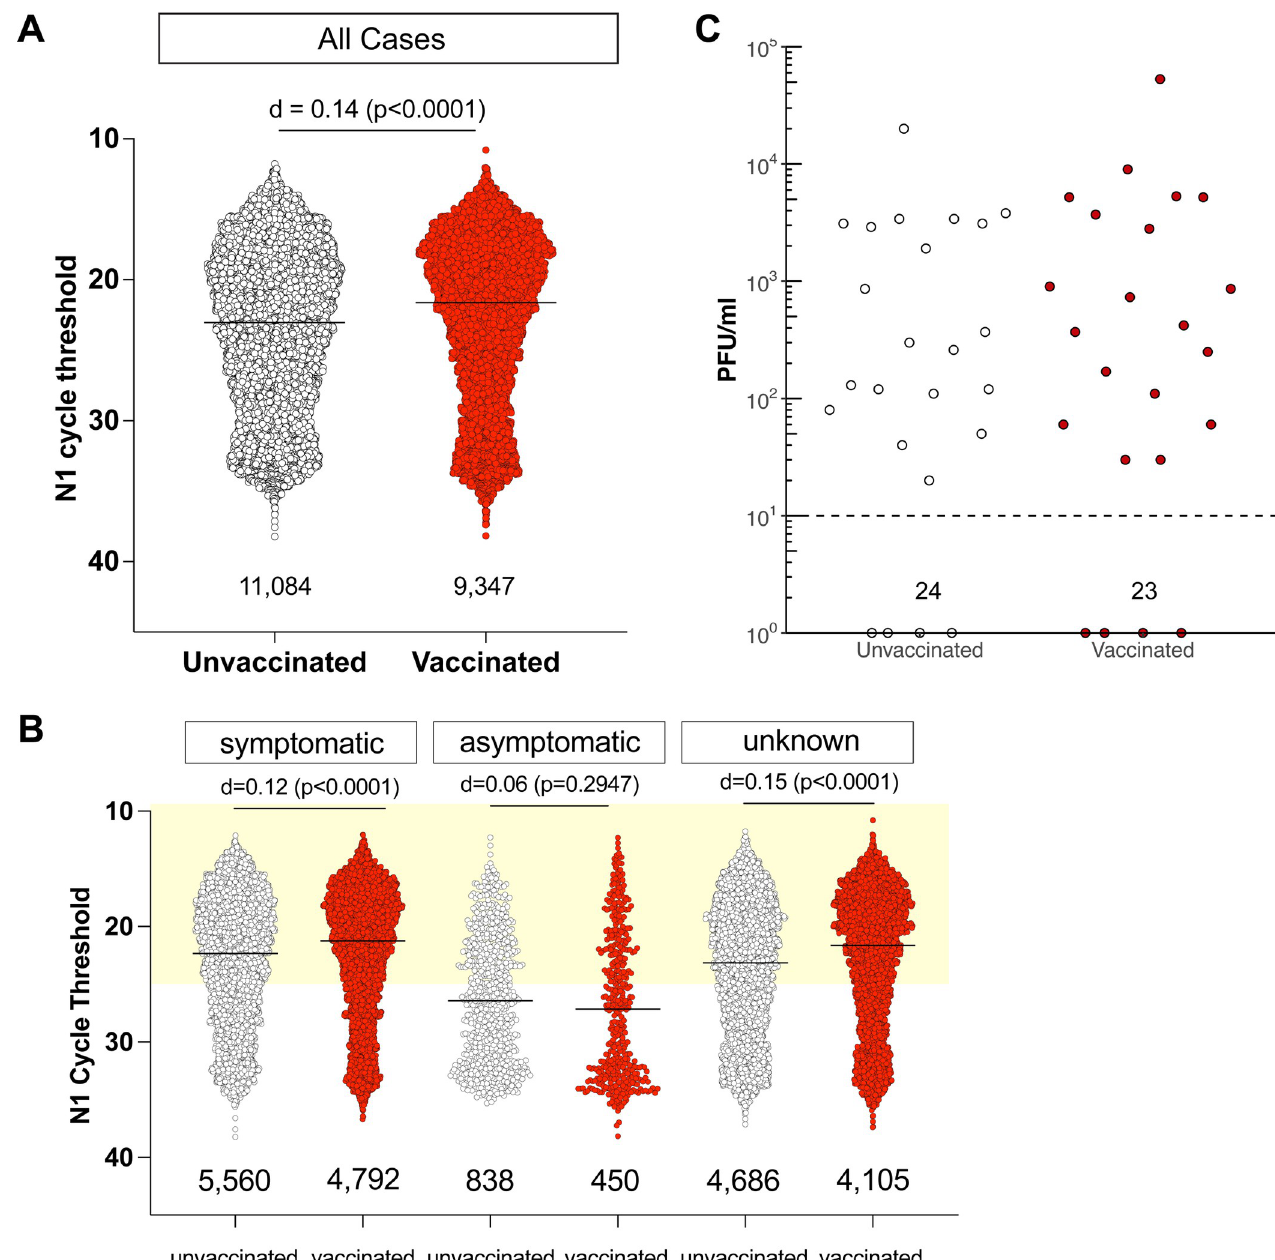
Fig 1. Individuals infected with SARS-CoV-2 despite full vaccination have low Ct values and shed similar amounts of infectious virus as unvaccinated individuals. A. N1 Ct values for SARS-CoV-2-positive specimens were grouped by vaccination status. RT-PCR was performed by Exact Sciences Corporation, responsible for over 10% of all PCR tests in Wisconsin during this period, using a qualitative diagnostic assay targeting the SARS-CoV-2 N gene (oligonucleotides identical to CDC’s N1 primer and probe set) that has been authorized for emergency use by FDA ( https://www.fda.gov/media/138328/ download )). See also Table 1 . An effect size of d < 0.2 is negligible. The number of samples in each group is listed under the dot plot. B. N1 Ct values for SARS-CoV-2-positive specimens grouped by vaccination status for individuals who were symptomatic or either asymptomatic or did not have any information, at the time of testing. Light yellow box indicates Ct values < 25. C. We performed plaque assays on Vero E6 TMPRSS2 cells on a subset of specimens. Specimens were selected by N1 Ct-matching between fully vaccinated and unvaccinated persons. Specimens from individuals with unknown vaccination status were excluded from the analysis. Infectious titers are expressed as plaque-forming units (PFU) per milliliter of specimen. Specimens underwent a freeze-thaw cycle prior to virus titration.